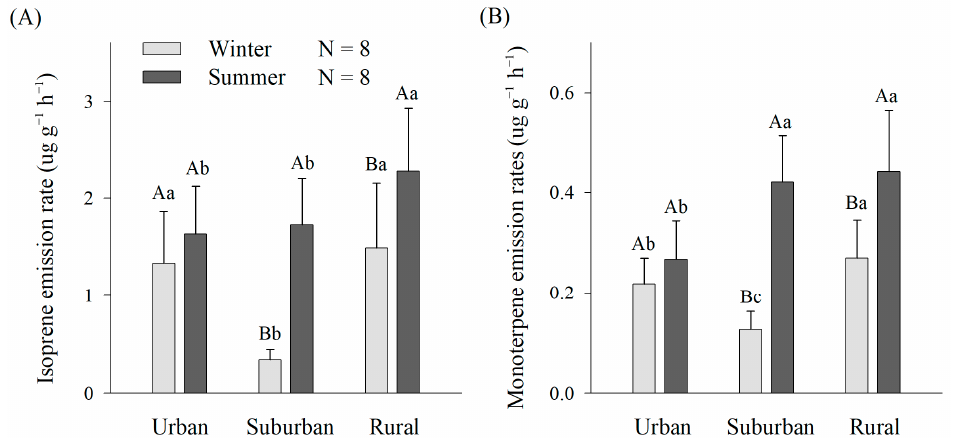
Figure 1. Seasonal patterns of the isoprene ( A ) and monoterpene ( B ) emission rates. The data are the mean ± SE of 24 replicates. The different lowercase letters denote significant differences of BVOC emission rates in between winter and summer at p ˂ 0.05 level.